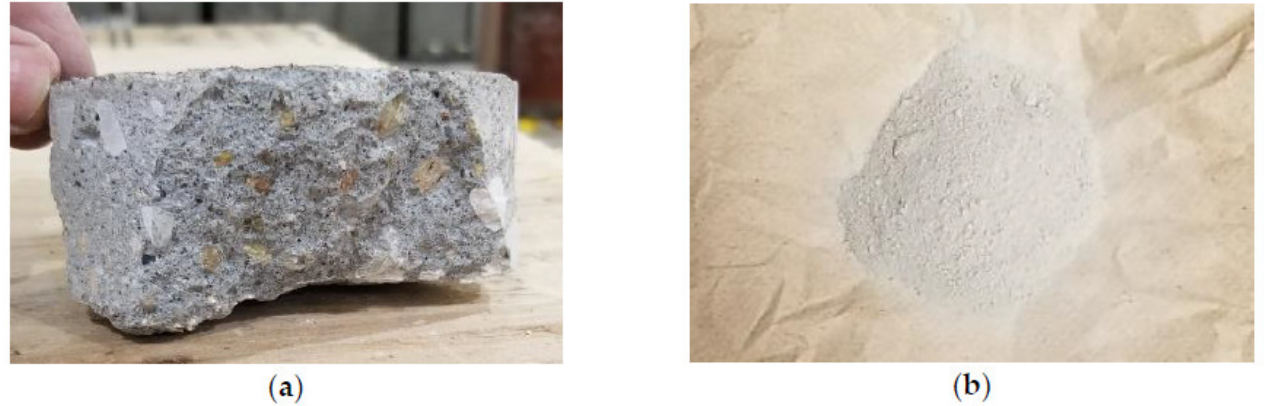
Figure 4. ( a ) Extracted core from the concrete specimen; ( b ) Concrete sample in pulverized